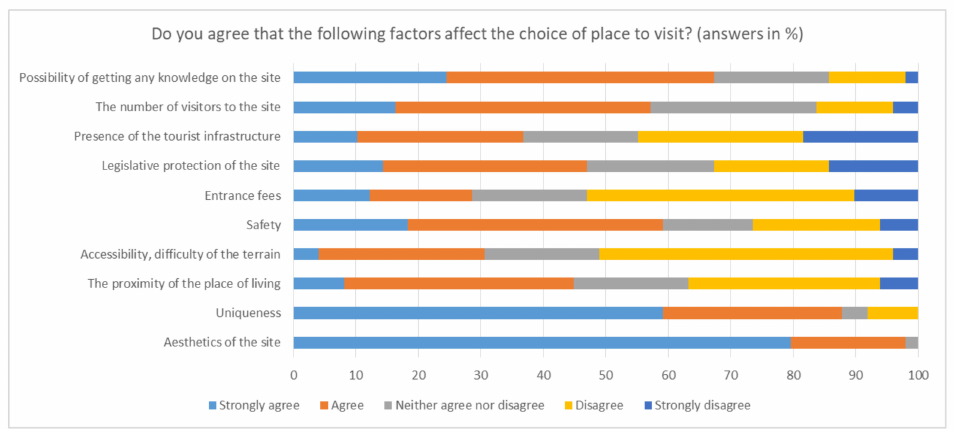
Figure 5. The results of the fourth group of questions: the aesthetics of the site is the most important factor that influences the visitor’s